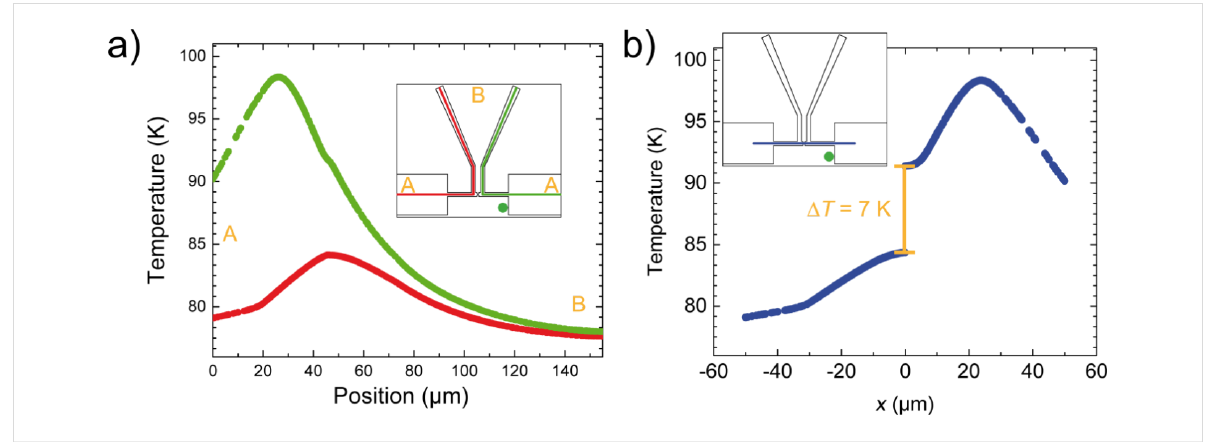
Figure 7: Simulations of the temperature distribution generated by a Gaussian heat source of 1.5 mW and with a diameter of 12 µm (FWHM) after 4 ms heating at a base temperature of 77 K. We implemented a structure similar to our device. The irradiation point (green dot) corresponds to the one used in our experiment. We calculate the temperature profile along different cross sections shown in the insets as red, green (a) and blue lines (b) (see insets). a) The temperature behavior along the red trace (red curve) and the green trace (green curve). b) The temperature behavior along y = 0 µm where the junction is located at position (0,0). The simulation shows a temperature difference of about 7 K.